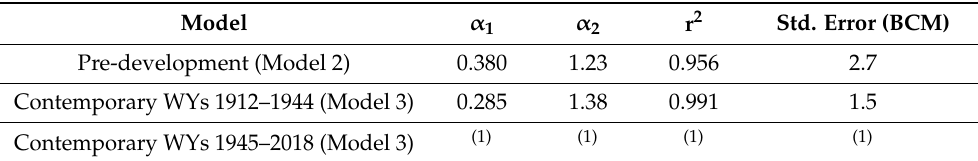
(Model 3) conditions. Flow units are in BCM per year.